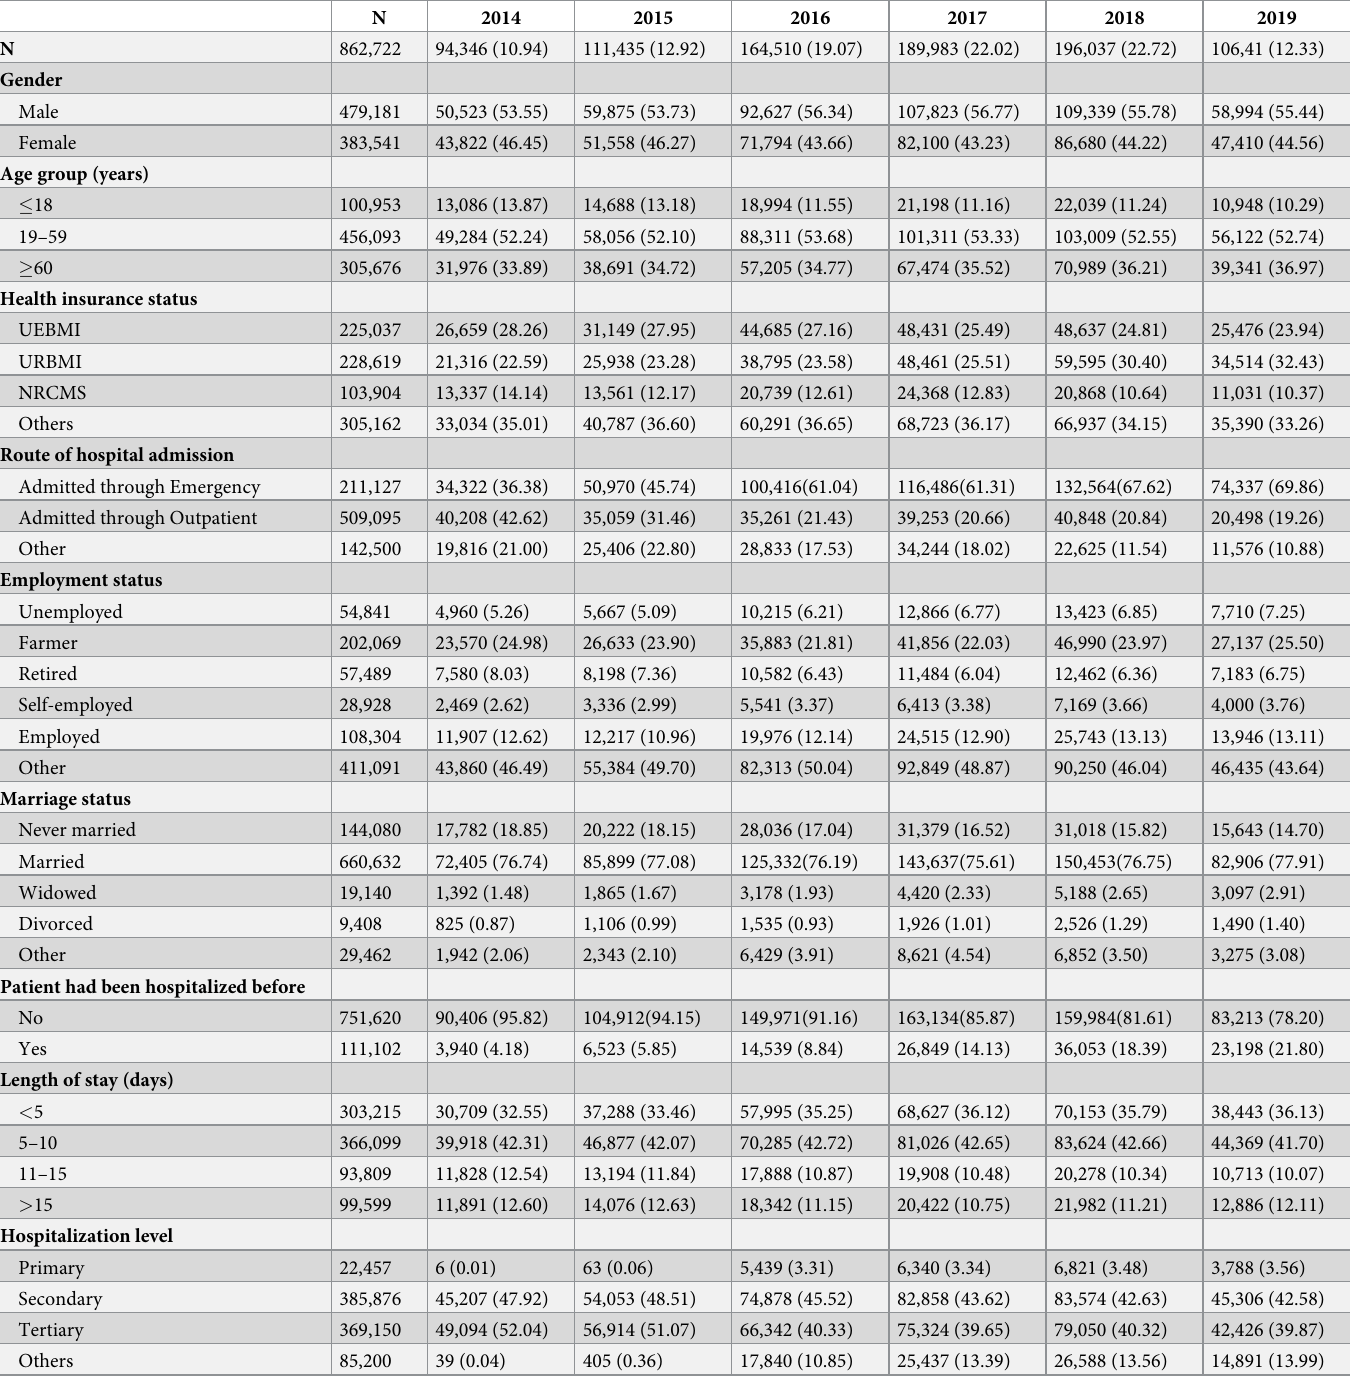
Table 1. Basic characteristics of